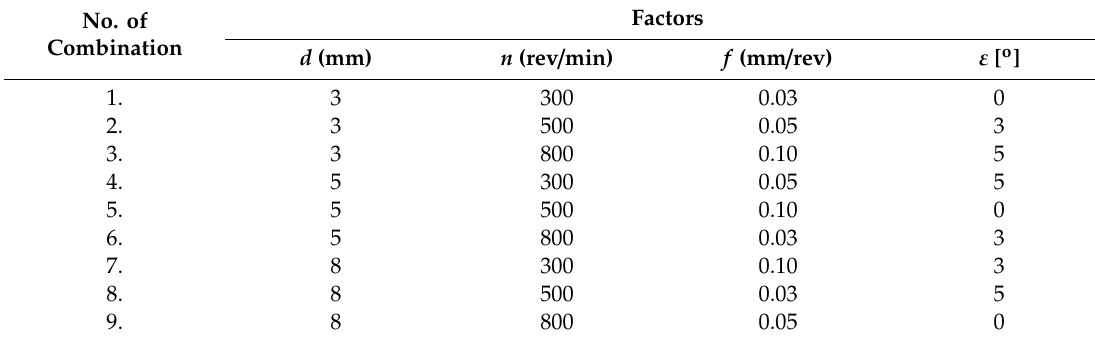
Table 2. Design of experiment.